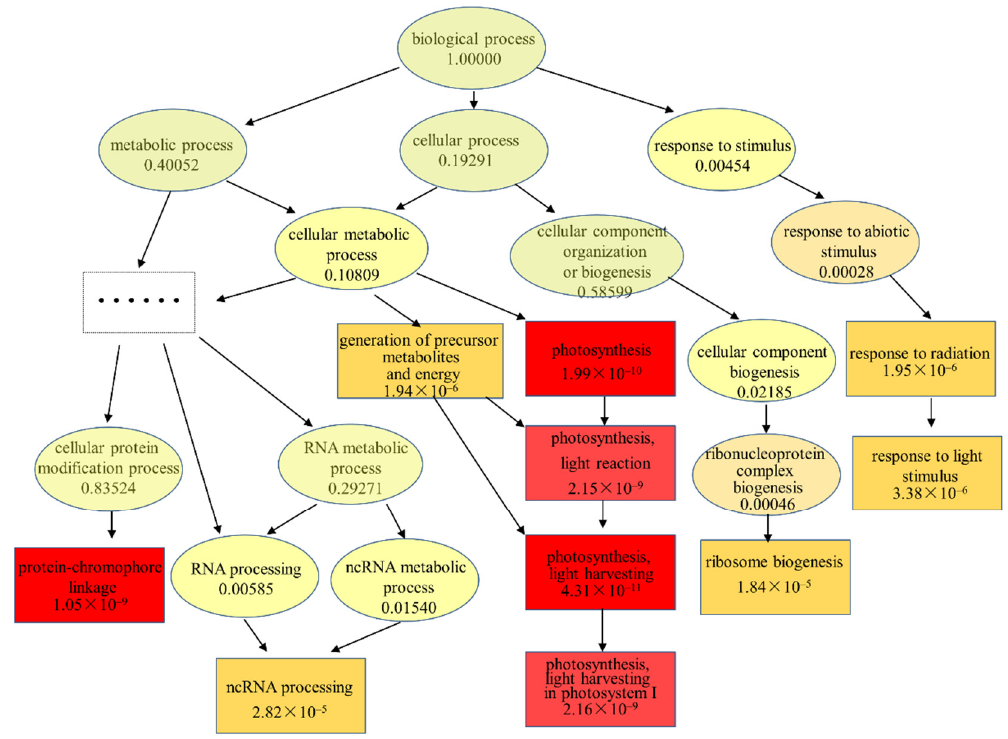
Figure 5. Significantly enriched Gene Ontology (GO) biological process terms and up-regulated differentially expressed genes (DEGs) in Scenedesmus obliquus exposed to tetracycline, compared to the control. The colors of the nodes denote the p -value (decreasing with the deepening of color from light yellow to deep red), which is also shown after each item. The numbers in each term represent DEGs and the total genes involved in this term. The top 10 GO terms are displayed in the rectangular frames.